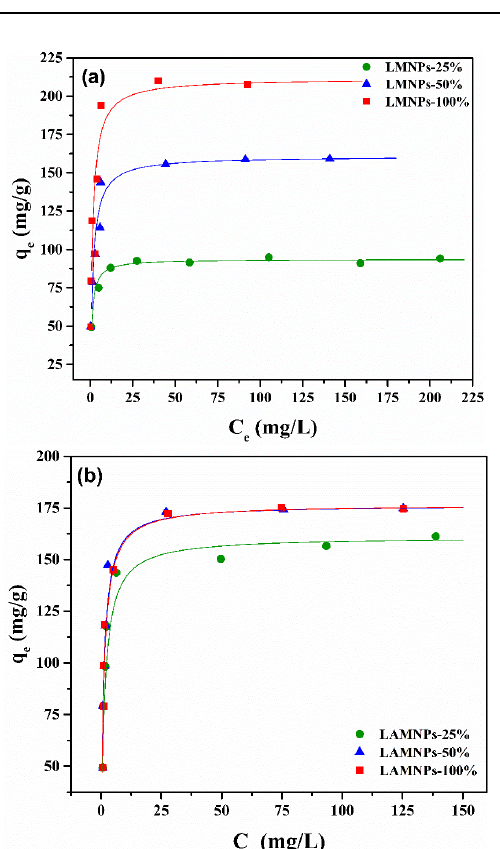
Figure 8. Isotherm experimental data of: ( a ) MB onto LMNPs surfaces and the fitted Langmuir curve at pH 10; and ( b ) AS-GR onto LAMNPs and the fitted Langmuir curve at pH 2.